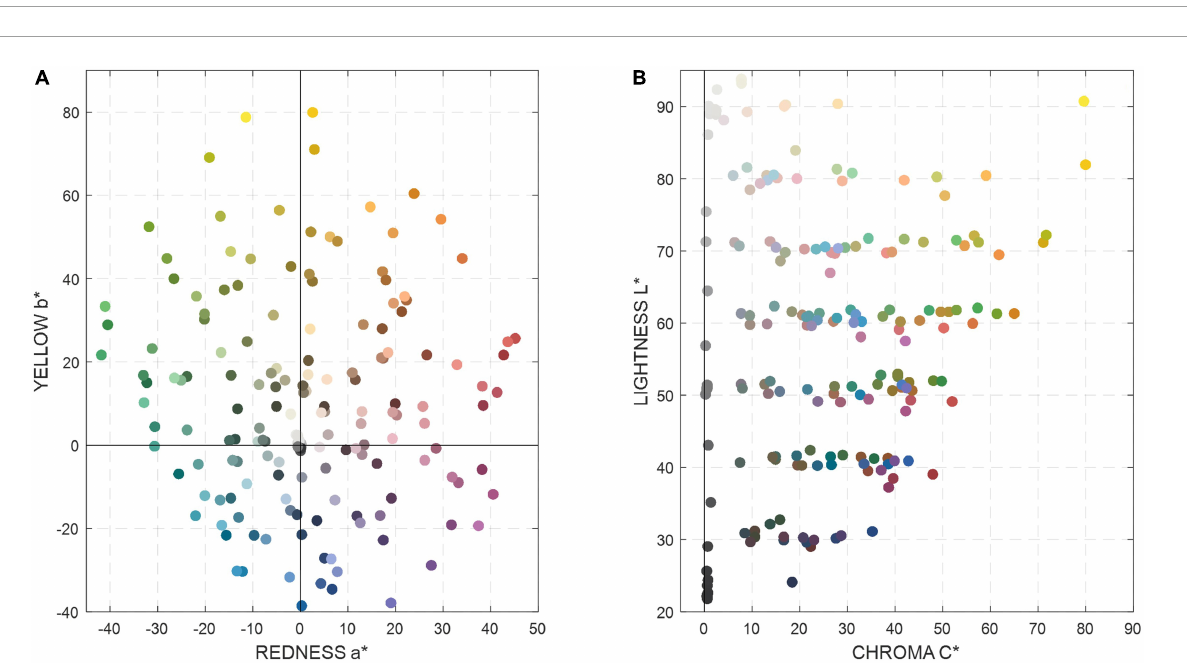
FIGURE4 The color distributions of the DC chart (232 matte patches) in CIELAB color space (A) a* b* plane and (B) L*C* plane.